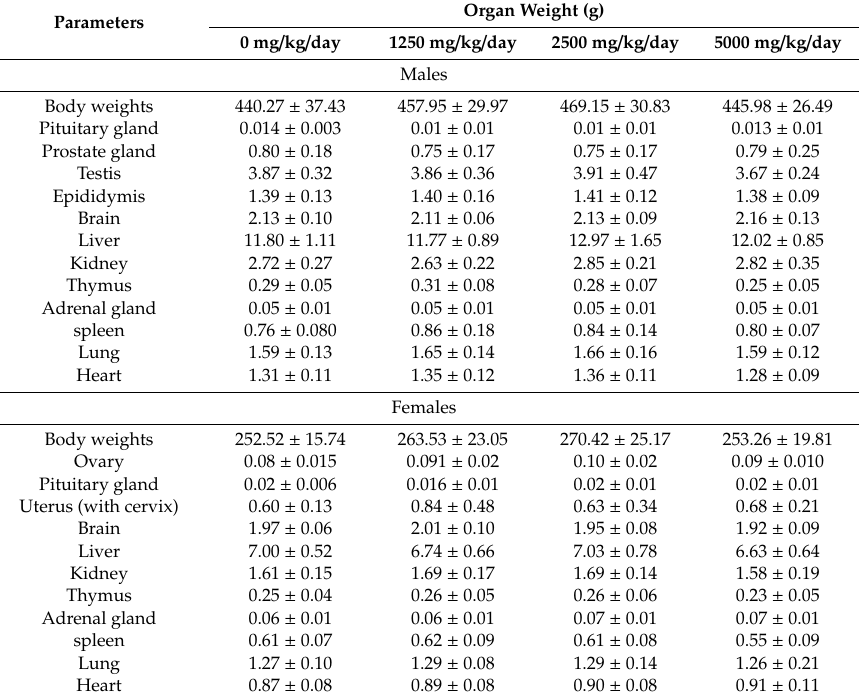
Table 5. Organ weights of SD rats orally administered frpfdZAL for 13 weeks.